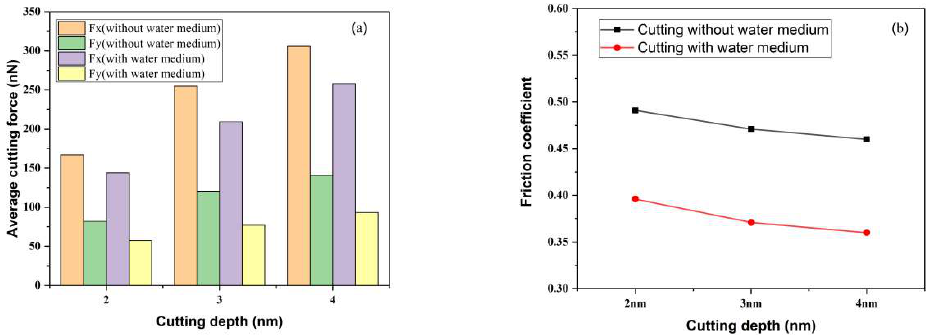
Figure 4. Cutting force and friction coefficient at different cutting depths (( a ) cutting force at different cutting depths ( b ) friction coefficient at different cutting depths).